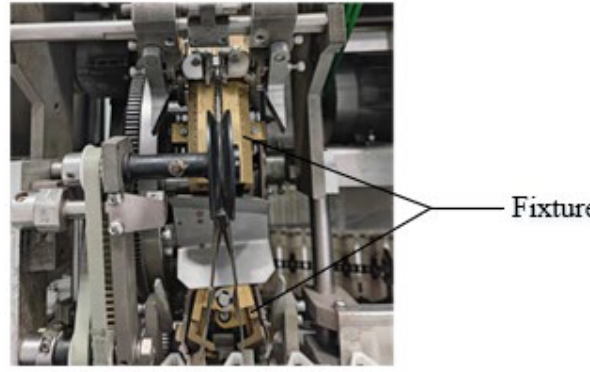
Figure 18. The fixture turntable clamping Figure 18. The f ixture turntable clamping mechanism.